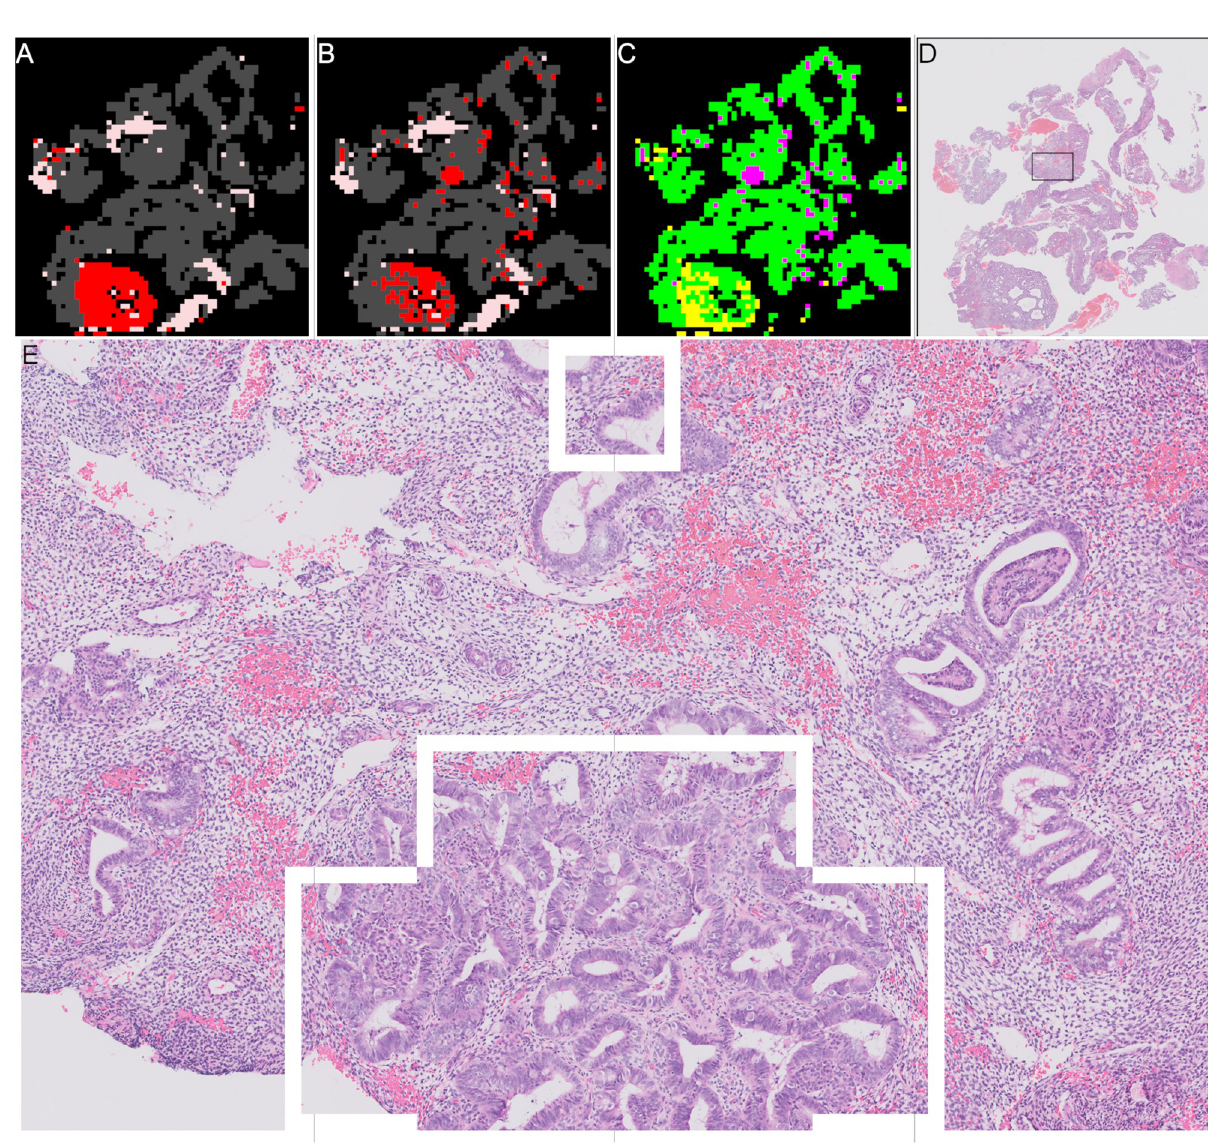
Fig 14. Example of patch classifications for correctly predicted “malignant” slide with some incorrect patches. (A) Annotation of “malignant” slide. Red shows “malignant” patches. Grey shows “other or benign” patches. Pink shows “blood or mucus”. (B) Patch results of “malignant” slide. Red shows “malignant” patches. Grey shows “other or benign” patches. Pink shows “blood or mucus”. (C) Difference between patch results and annotation. Green, prediction correct. Yellow, prediction = “other or benign”, annotation = “malignant”. Magenta, prediction = “malignant”, annotation = “other or benign”. (D) Thumbnail of slide showing region in (E) as black box. (E) Zoomed in detail of region where patch predictions do not match